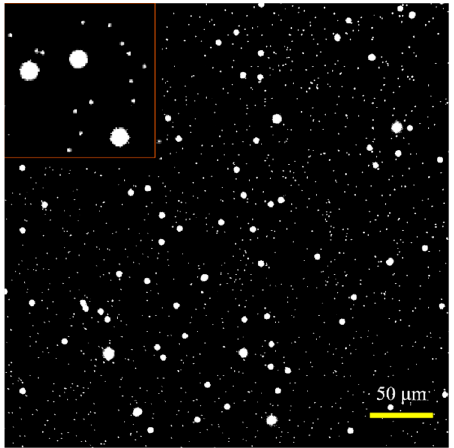
Figure 11. Fluorescence image of mixed micropillars and microspheres solution. The shape of the micropillar is not distinguishable from the image due to the low resolution. The red square in the upper left corner shows the zoom-in particle image.